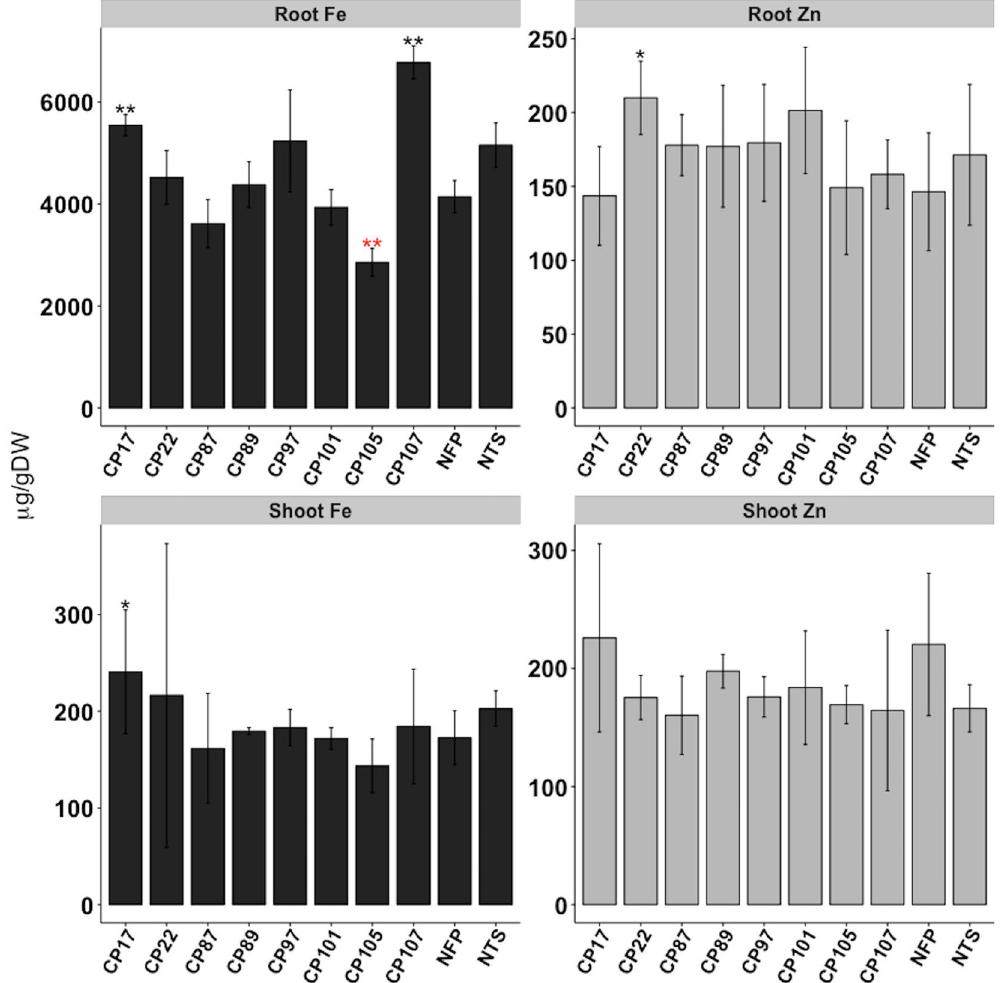
Figure 3. Metal content in roots and shoots of CP lines. Iron (Fe) and zinc (Zn) in the shoots and the roots of 18 d seedlings of T3 CP lines. Values are the mean of three biological replicates ( ± SD). Black and red asterisks above the bars indicate statistically higher and lower significant differences calculated using Student’s T test, respectively, in comparison to the control line NFP ( * P < 0.05; ** P < 0.01). NTS is the segregating NFP sibling that does not contain the PaCRTI - ZmPSY